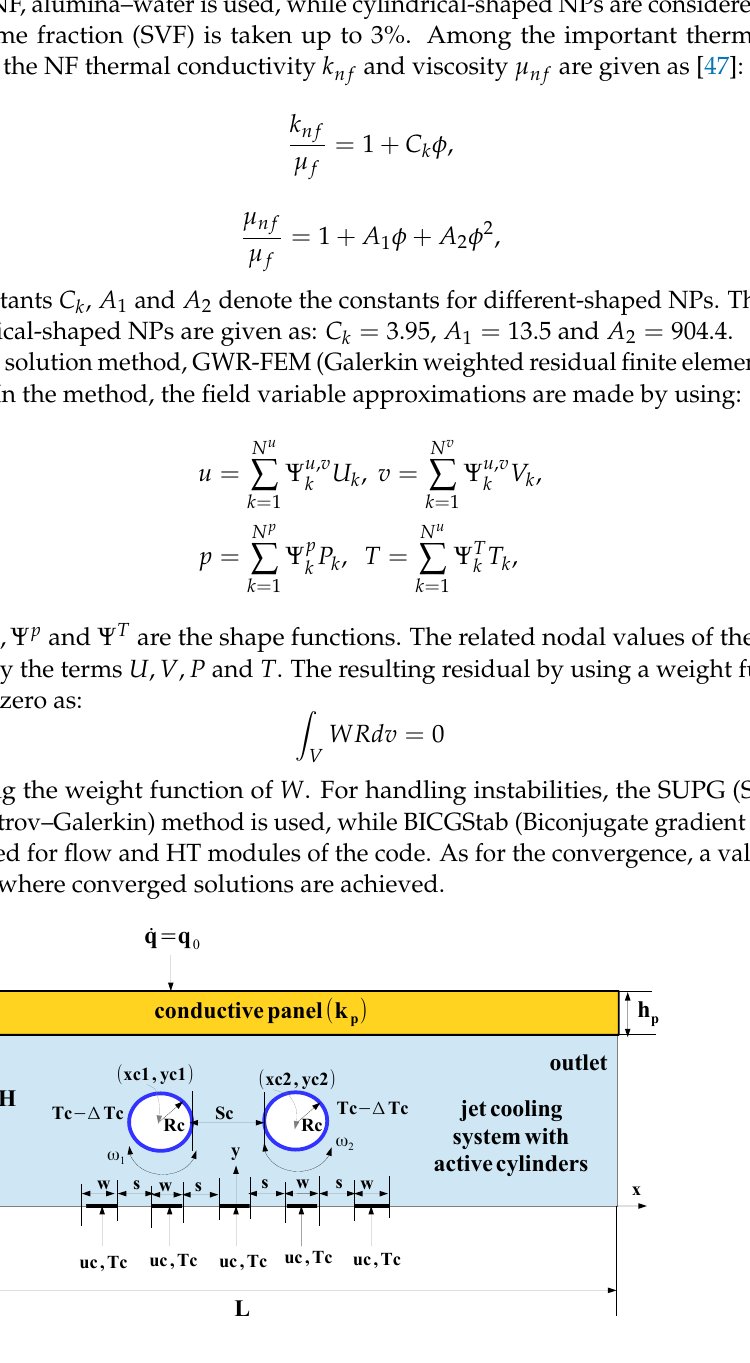
Figure 1. Conductive panel cooling system with slot jet impinging and active RCCs (not to scale). Table 1. Thermophysical properties of water and alumina at 25 ◦ C [48].